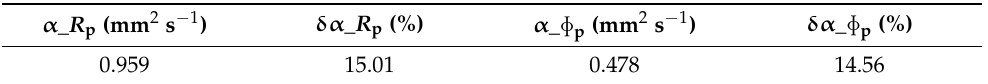
Table 7. Thermal diffusivity deduced from Equation (5) ( R p ) and Equation (6) ( F p ) and related uncertainties δ (%).